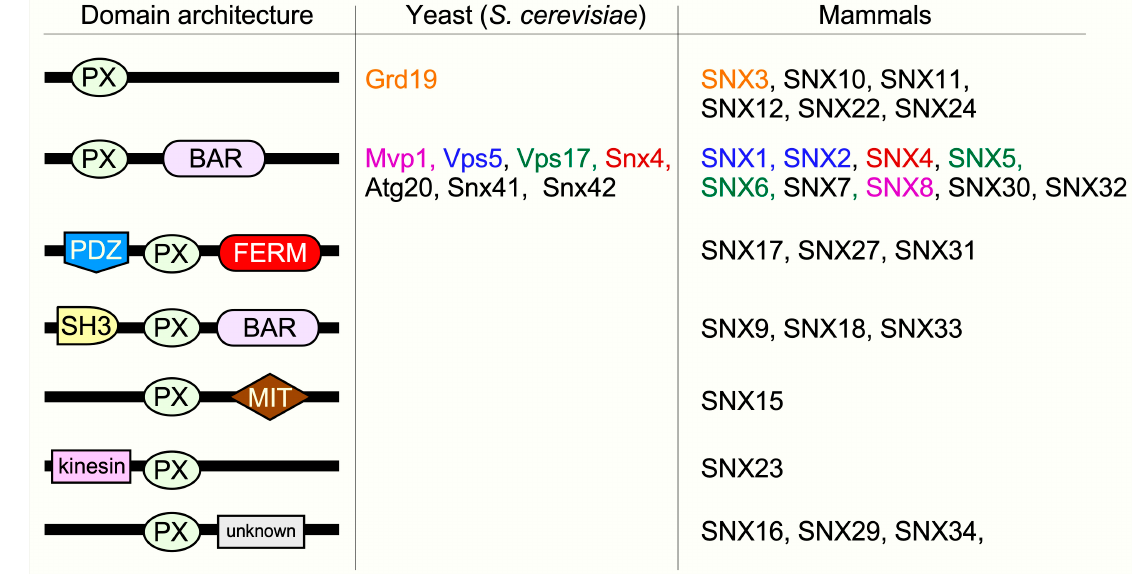
Figure 2 Figure 2. Structural classification of SNX subfamilies. The domain architecture describes the functional domains within different SNX subfamilies. The phox homology (PX) domain denotes the highly conserved lipid-binding domain that unifies the SNX protein family. It enables SNXs to bind to specific phosphoinositides (PtdIns) which mark different membrane sur- faces. SNX-BAR (Bin/Amphiphysin/Rvs) proteins contain coiled-coil regions that enhance membrane binding, membrane remodeling, and protein-protein interactions. PDZ (postsynaptic density 95/discs large/zonula occludens) domains, FERM (protein 4.1/ezrin/radixin/moesin) domains, SH3 (SRC homology 3) domains, MIT (microtubule interacting and trafficking) domains, and Kinesin motor domains play a role in membrane binding, substrate recognition, kinase activity regulation, protein trafficking, and binding/movement along microtubules. The color code signifies yeast and mammalian